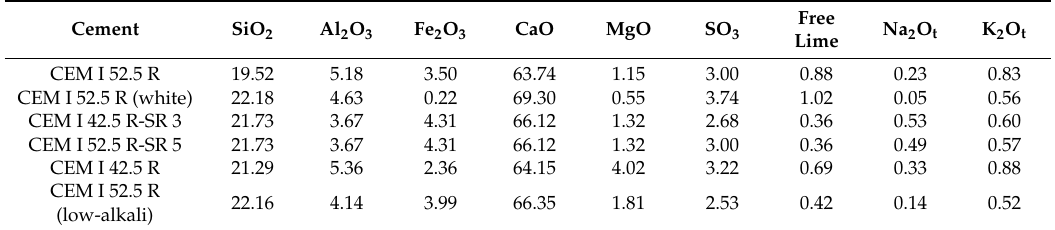
Table 1. Chemical compositions of cements determined according to EN 196-2 [4], and the total alkalis measured by atomic absorption spectrometry (%).